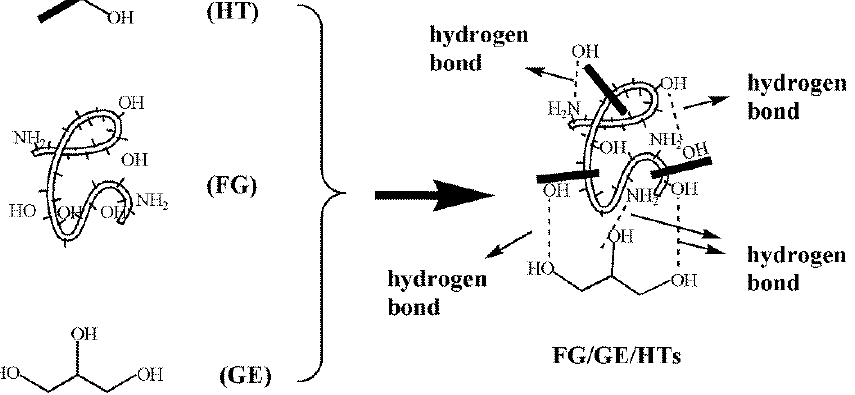
Scheme 1. Schematic illustration of the mechanism of HTs in the FG/GE composites.